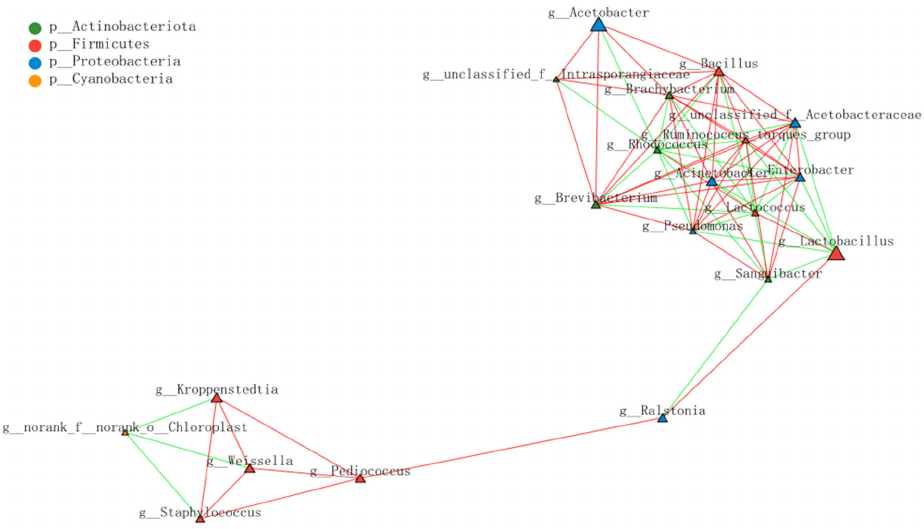
Figure 4. Horizontal correlation network analysis of bacteria genera in fermented grain samples. Note: The size of the regular triangle represents the abundance of species, and the different colors represent different phyla. The colors of the line represent positive and negative correlations: red represents positive correlations and green represents negative correlations. The more lines there are, the more closely related the species is to other species.